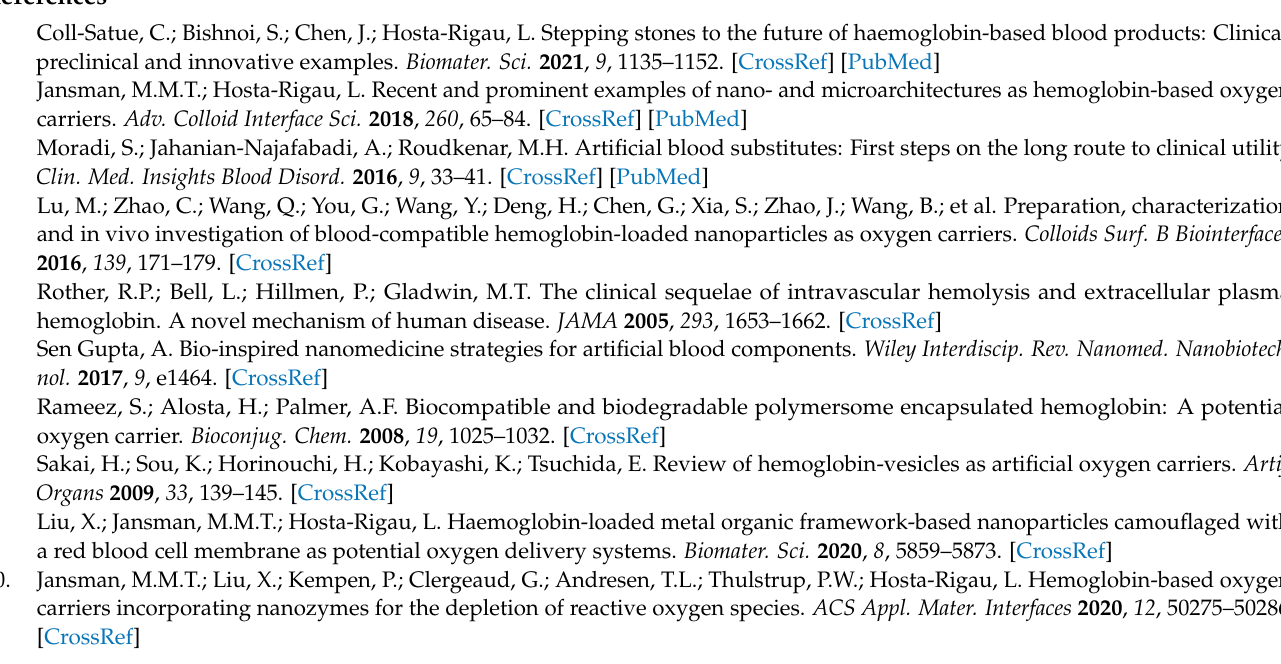
Table S3: Effects of the PLGA concentration on the resulting HbNPs, Table S4: Effects of the PVA concentration on the resulting HbNPs, Table S5: Effects of the PVA volume on the resulting HbNPs, Table S6: Effects of the DCM:EA ratio on the resulting HbNPs, Figure S1: SEM image of the bare PLGA-NPs, Figure S2: size and zeta potential histograms comparing PLGA-NPs and HbNPs-26, Figure S3: CryoTEM image of the optimized HbNPs, Figure S4: UV-vis spectra following purging of the HbNPs with compressed air and N 2 after 4 h incubation with blood cells (a), Phase contrast images of the blood cells before (b) and after (c) incubation with the optimized HbNPs, Figure S5: UV-vis spectra following purging of the HbNPs with compressed air and N 2 after 4h incubation with RAW cells (a). Phase contrast images of the RAW cells before (b) and after (c) incubation with the optimized